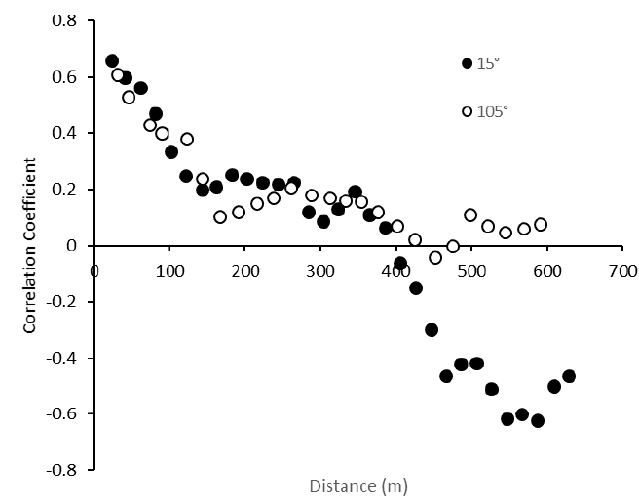
Figure 6. Directional correlograms at 15° and 105°.